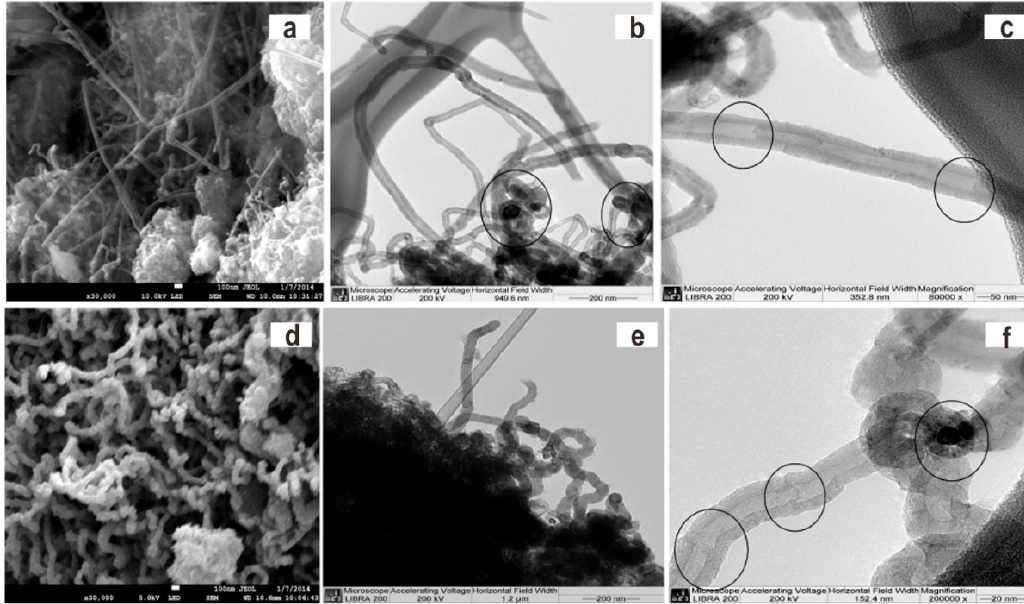
Figure 3. Field emission scanning electron microscopy (FE ‐ SEM) and TEM images of